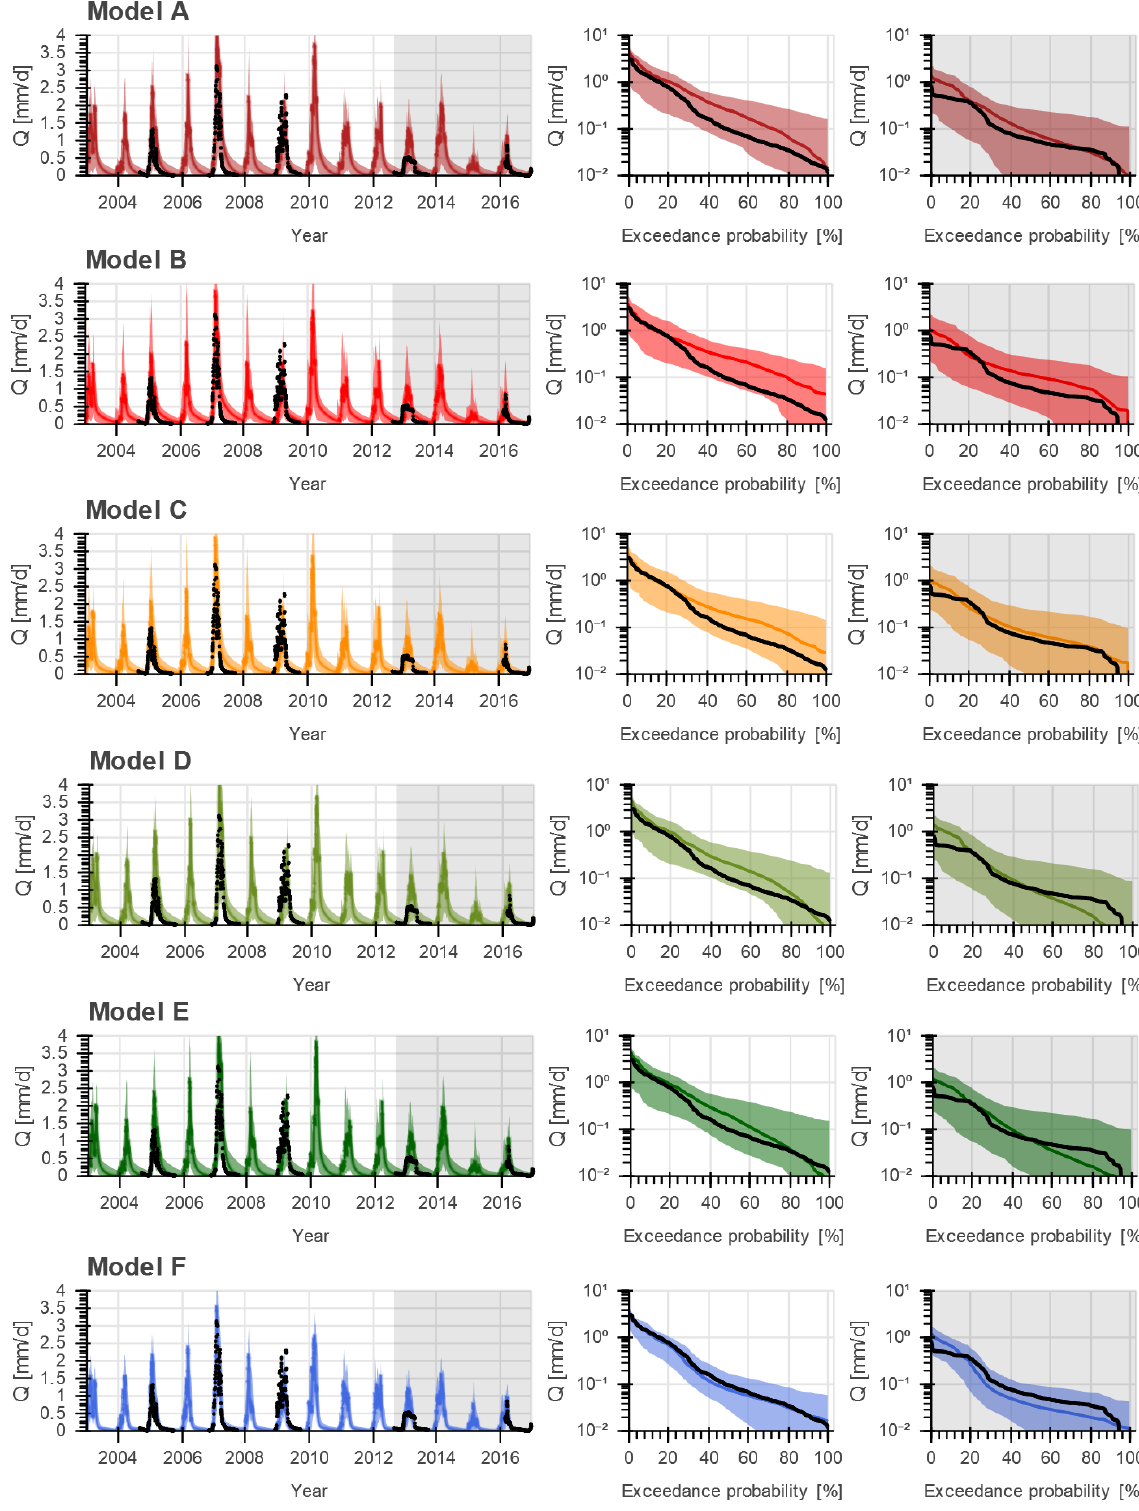
Figure 9. Range of model solutions for Models A to F. The left panels show the hydrograph and the right panels the flow duration curve of the recorded (black) and modelled discharge: the line indicates the solution with the highest calibration objective function with respect to multiple variables ( D E , ES Q cal ) and the shaded area the envelope of the solutions retained as feasible. The data in the grey shaded area were used for